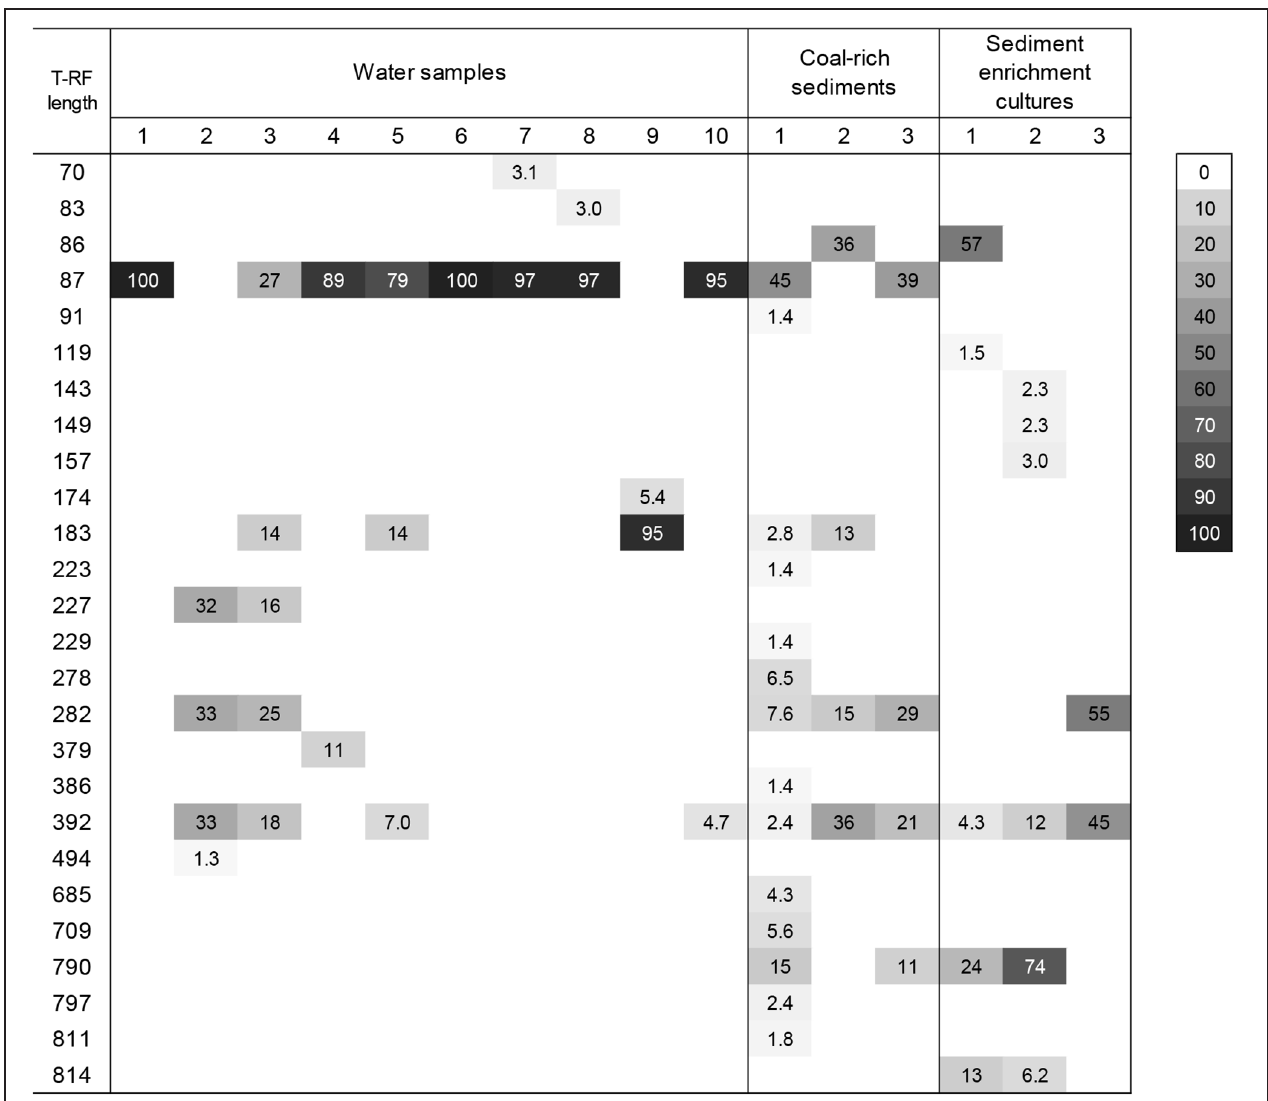
FIGURE 5 | Heatmap showing the T-RF found in Archaeal 16S rRNA gene T-RFLP fingerprints from different groundwater samples collected from deep aquifers of coal-rich sedimentary basin, coal-rich sediment